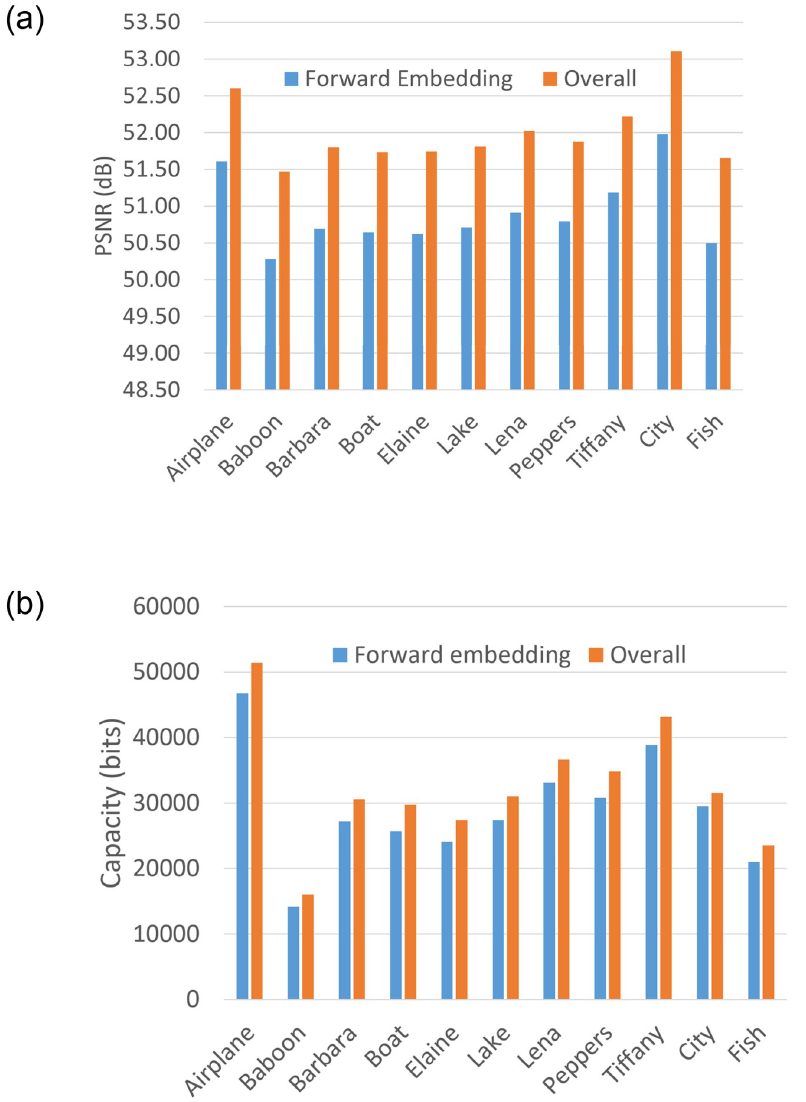
Fig 5. Rate-distortion performance with proposed dPVO for test images: (a) PSNR and (b)